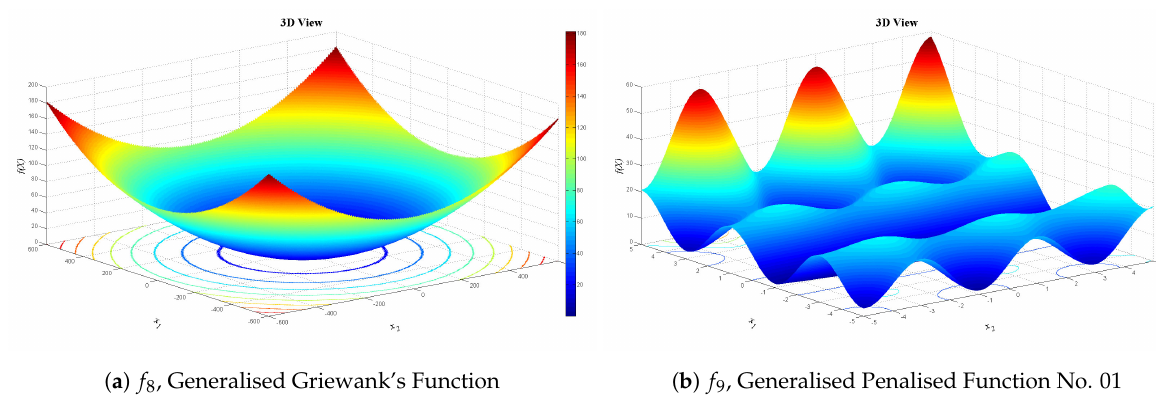
Figure 7. Multimodal benchmark mathematical functions f 8 and f 9 in a 3D